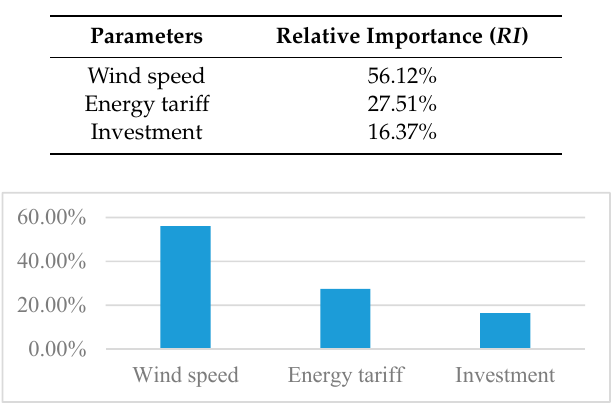
Figure 4. Relative importance ( RI ) through ANN: variables that most impact the NPV.